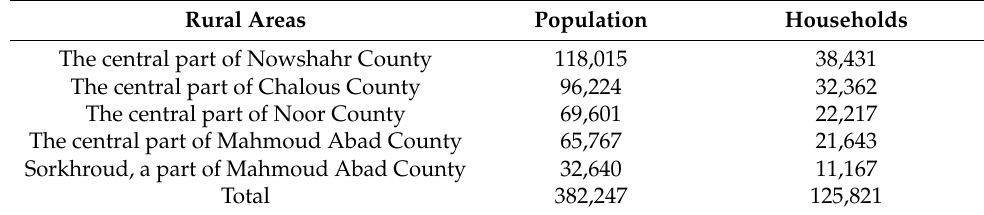
Table 1. Number of rural population and households in the study area in 2016 [42].